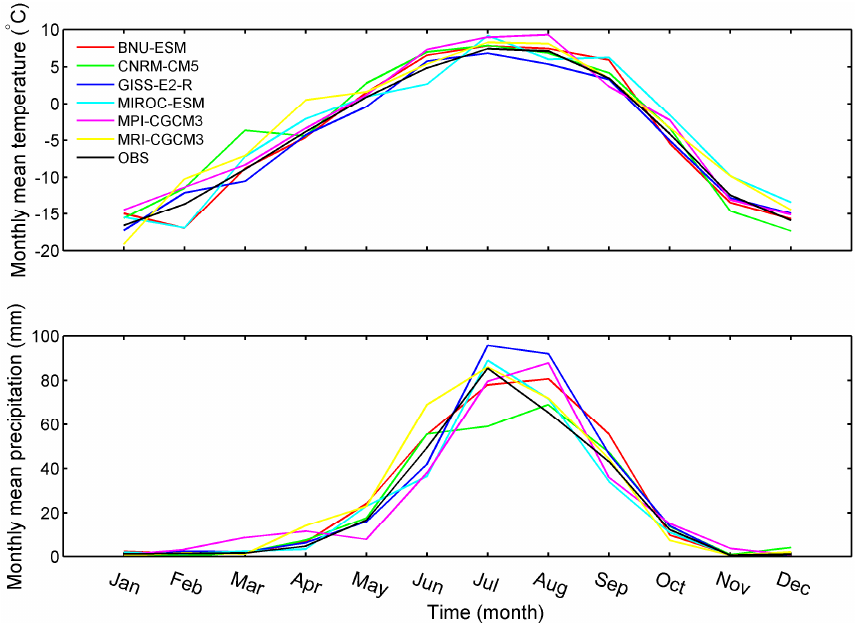
Figure 4. Monthly mean of the past simulation. Table 4. R and RMSE values of the daily meteorology data from the six GCMs and meteorological station. GCMs